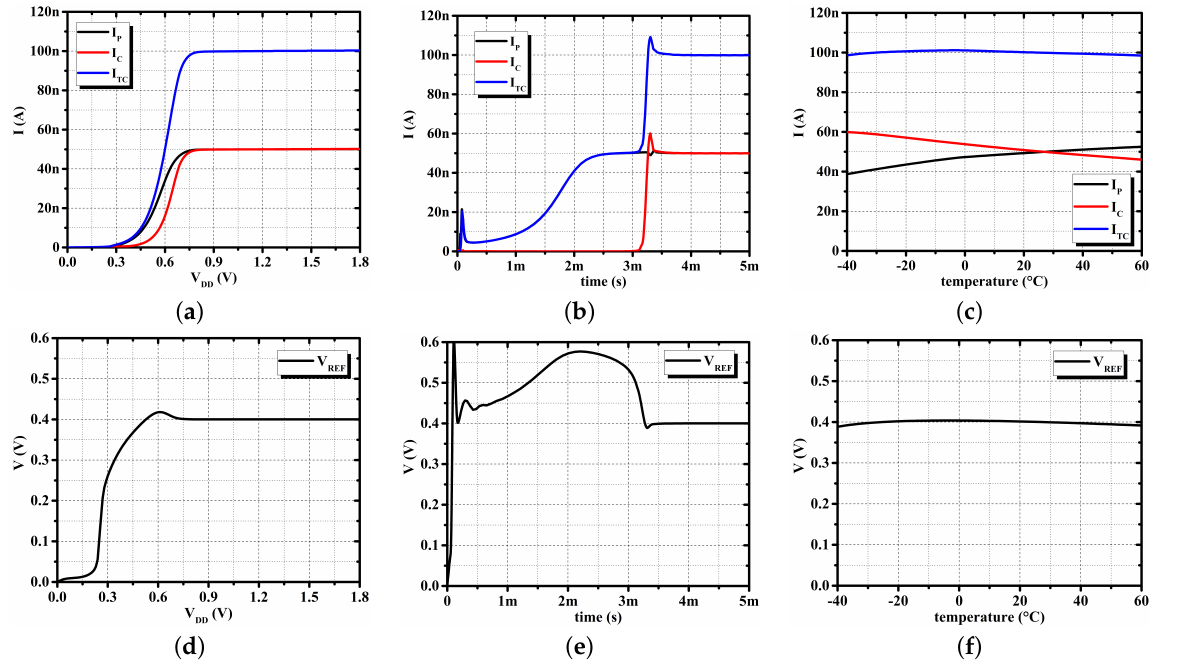
Figure 13. Current/voltage reference post-layout simulation. ( a ) I p , I c , and I TC DC characterization. ( b ) I p , I c , and I TC transient response. ( c ) I p , I c , and I TC temperature characterization. ( d ) V REF DC characterization. ( e ) V REF transient response. ( f ) V REF temperature characterization.